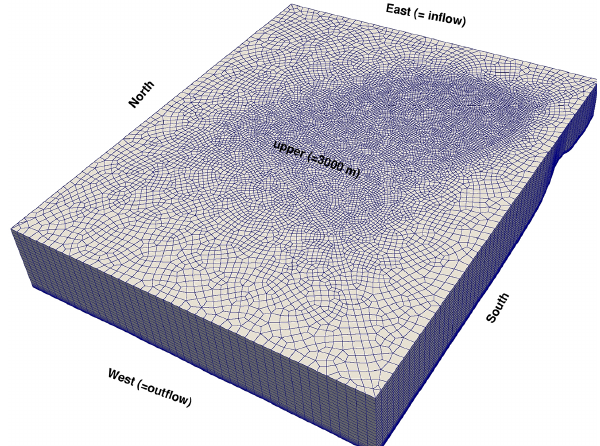
Figure 5. The discretized domain, (cid:127) . Horizontal resolutions reach from 50m close to the valley slopes to 200m. The vertical terrain following extrusion is not equidistant but rather features a mesh re- finement in the lower 10% of the height in order to capture bound- ary layer